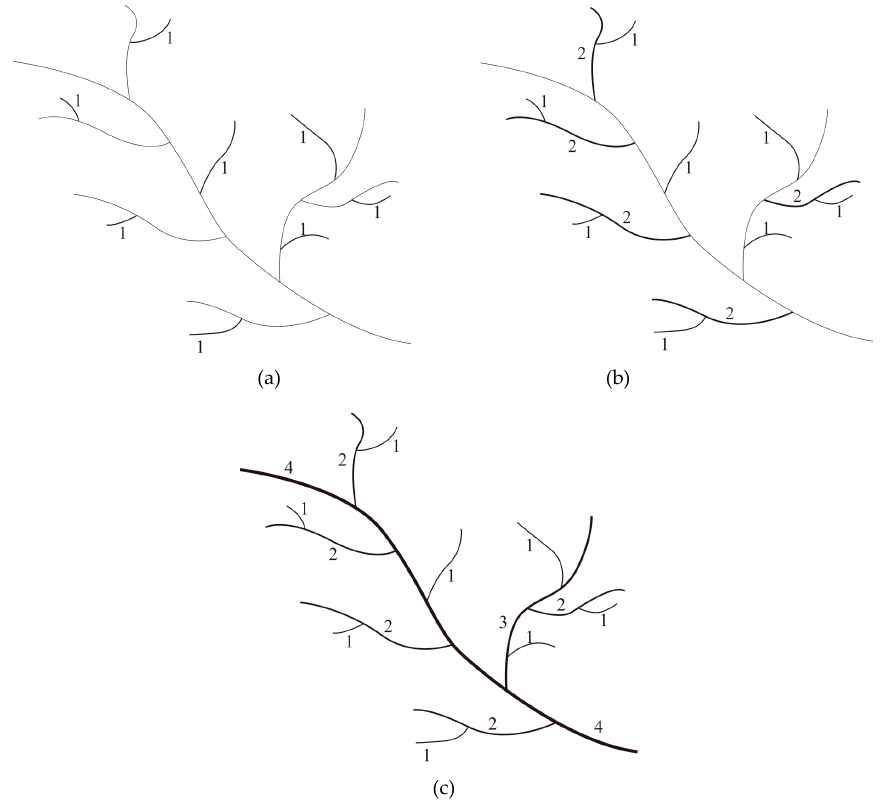
Figure 5. Procedures of the automated coding method for dendritic river features: ( a ) coding the terminal tributaries, ( b ) coding of second-order streams and ( c ) final results of stream coding.